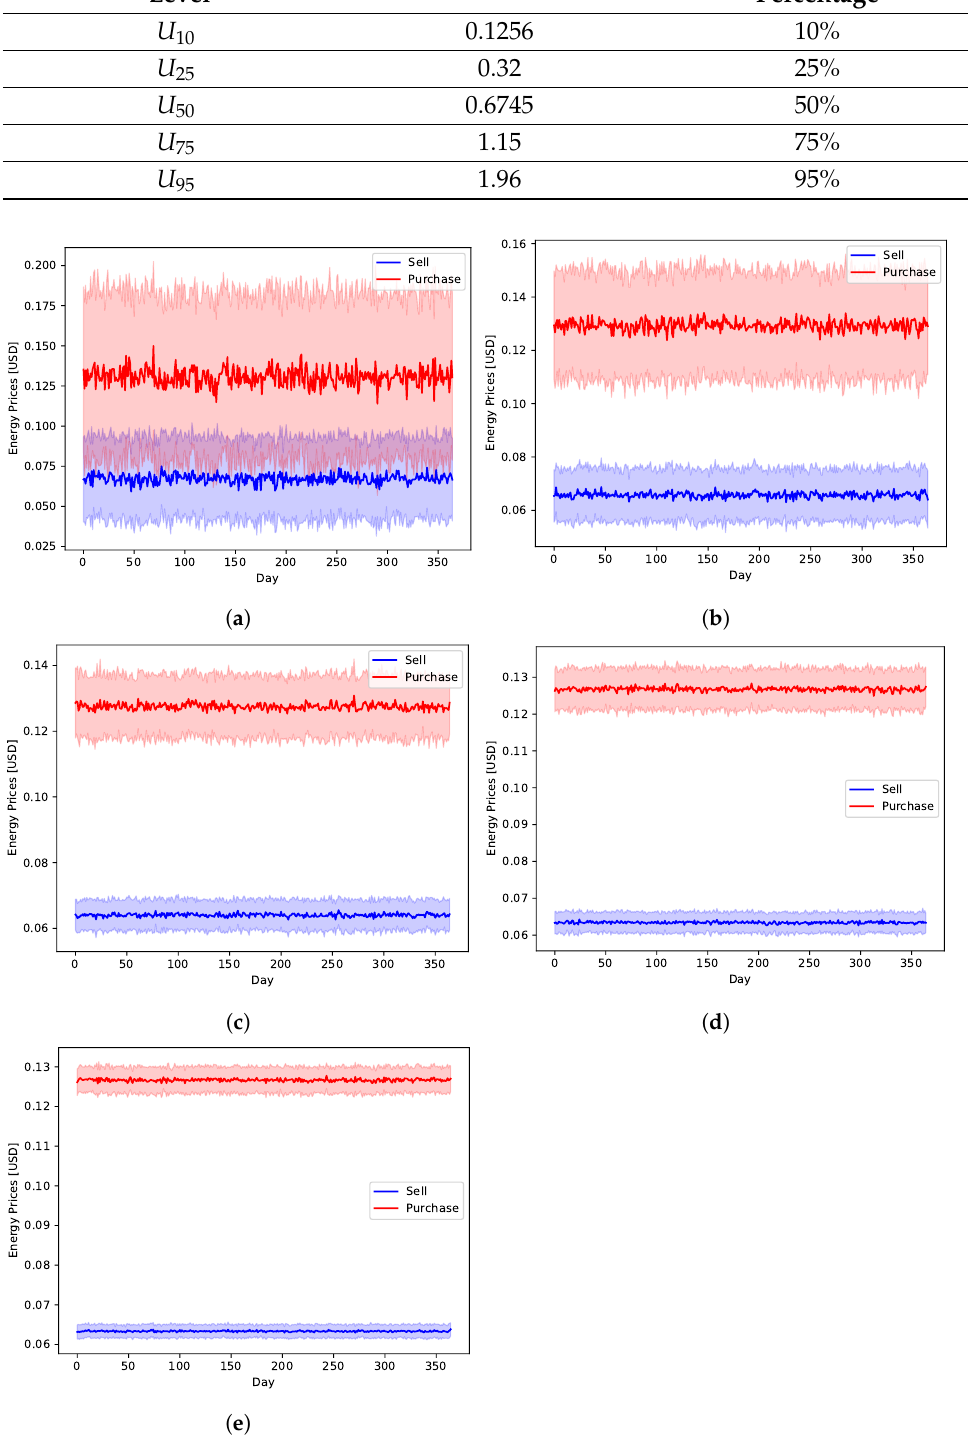
Table 4. The used global uncertainty levels in the conducted experimentation. Each certainty level implies a specific sample percentage, which is the portion of the drawn samples that swap around ± half of the mean values of the considered parameter. Uncertainty Samples Z-Score Level Percentage U 10 0.1256